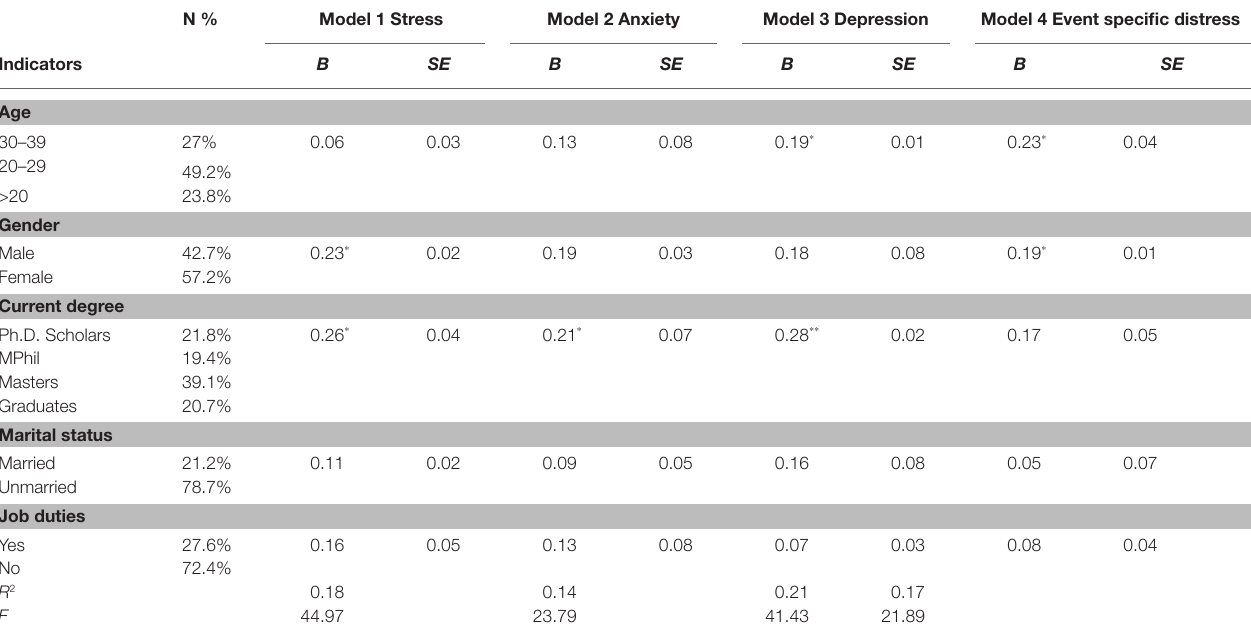
TABLE 1 | Connexion between sociodemographic features and psychological well-being and mental health of students. N